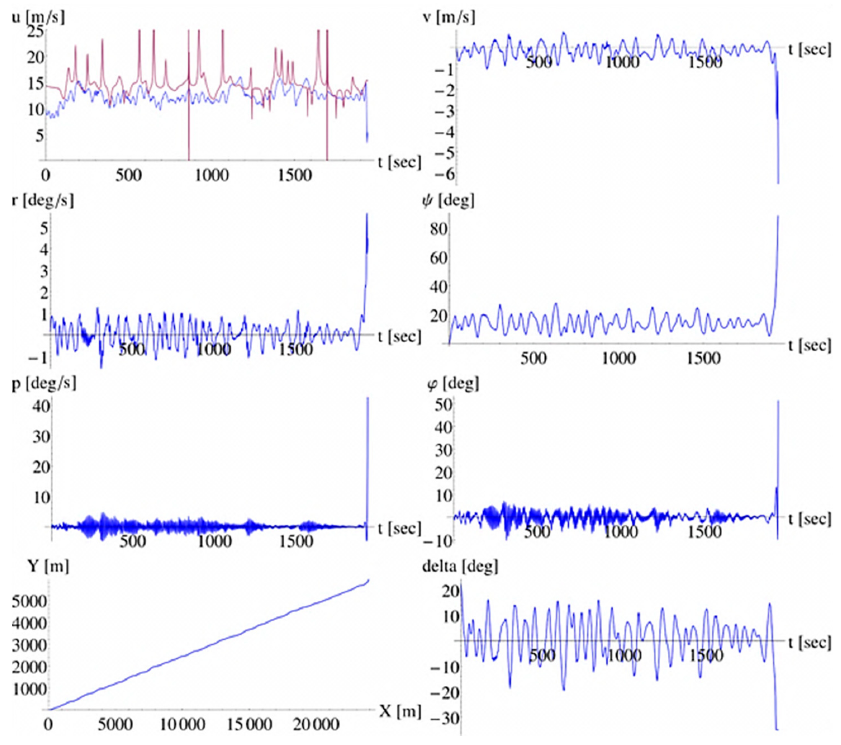
Figure 5. Simulation of a severe broaching incident ( GM = 3.0 m, 𝜓 (cid:2928) = 15.0 (cid:2925) ).